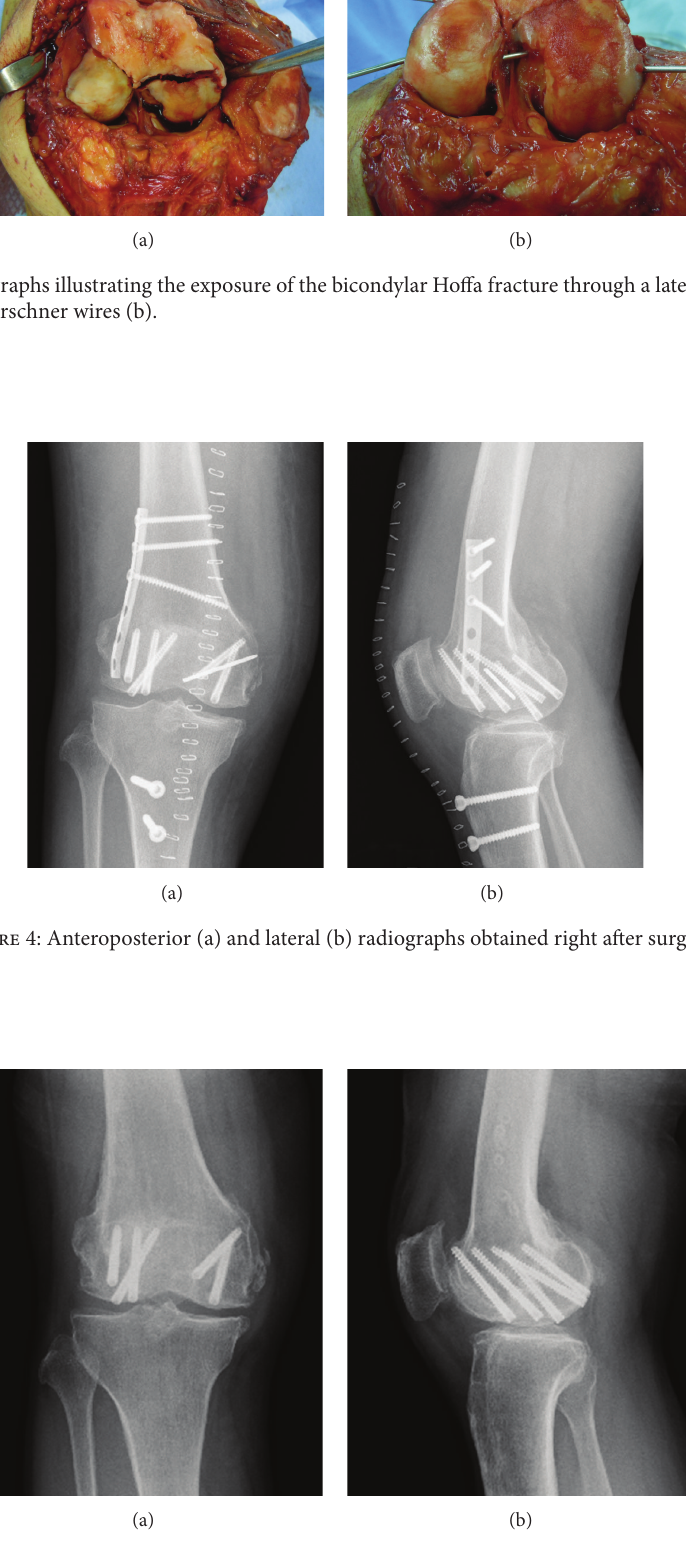
Figure 5: Anteroposterior (a) and lateral (b) radiographs obtained at the latest follow-up, at 2 years and 7 months after